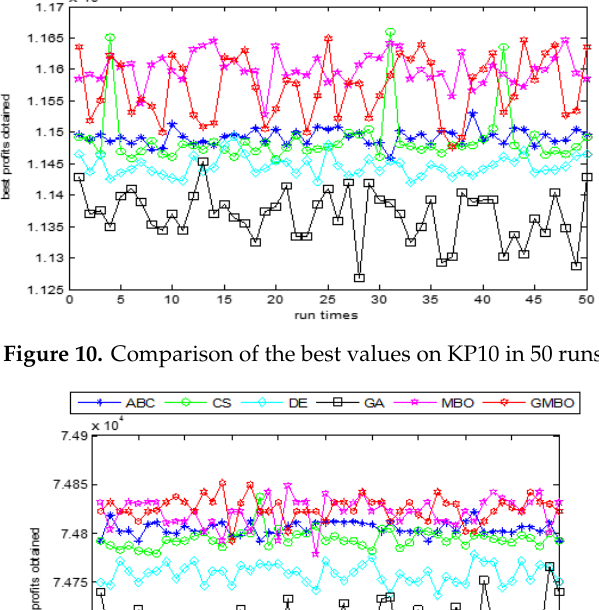
Figure 9. Comparison of the best values on KP9 in 50 runs.